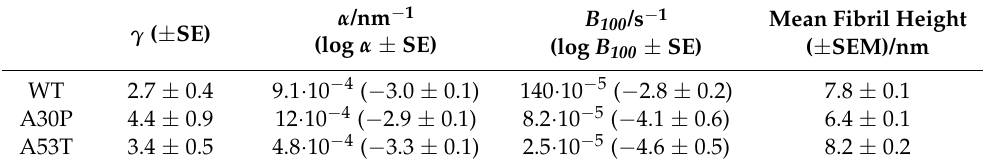
Figure 3. Fibril length and height distributions extracted from AFM images of the WT, A30P and A53T α-synuclein amyloid fibrils undergoing fragmentation by controlled sonication. Histograms representing normalised fibril length distributions ( a ) and height distributions ( c ) are shown using the same length and height scales, respectively, for comparison. Cumulative distribution functions of the same length distributions ( b ) and height distributions ( d ) are also shown to facilitate visualisation of the changes in the length distributions and the consistency of the height distributions for the duration of the controlled sonication. Statistics of the quantitative image analysis are shown in Supplementary Table S1. Table 1. Parameters describing the best-fit pure fibril fragmentation model to the sonication-induced length decay data (Figure 3). The γ parameter describing how the fragmentation rate constants depend on fibril length and the α parameter describing the typical magnitude of the division rate constants are shown with the length-dependent division rate constants B ( x ) = ( α · x ) γ s − 1 [26,27] at fibril length x = 100 nm ( B 100 ). The parameters are shown with their respective standard errors (SE) estimated as described in the Methods section. The average heights of the fibril particles throughout the sonication procedure are also shown with their standard error of mean